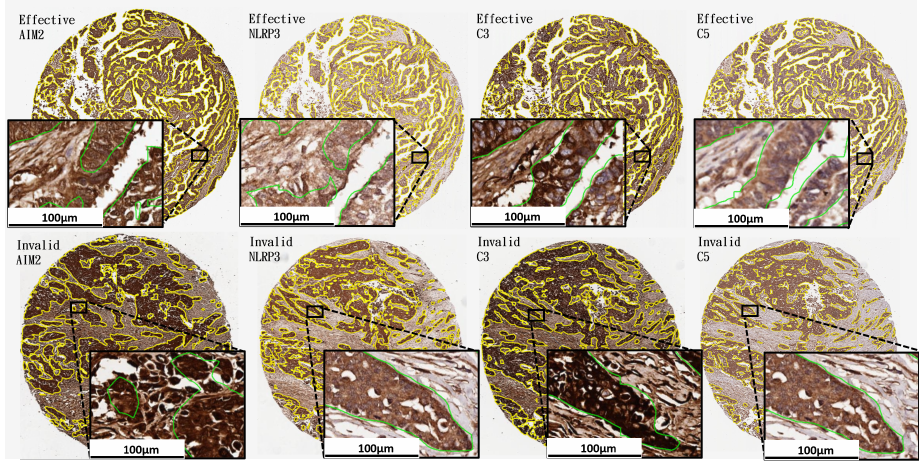
Figure 1. Sample tumor-like tissue selection results with high magnification views at 100 µ m of the four kinds of IHC stained data by the proposed weakly supervised tissue selection